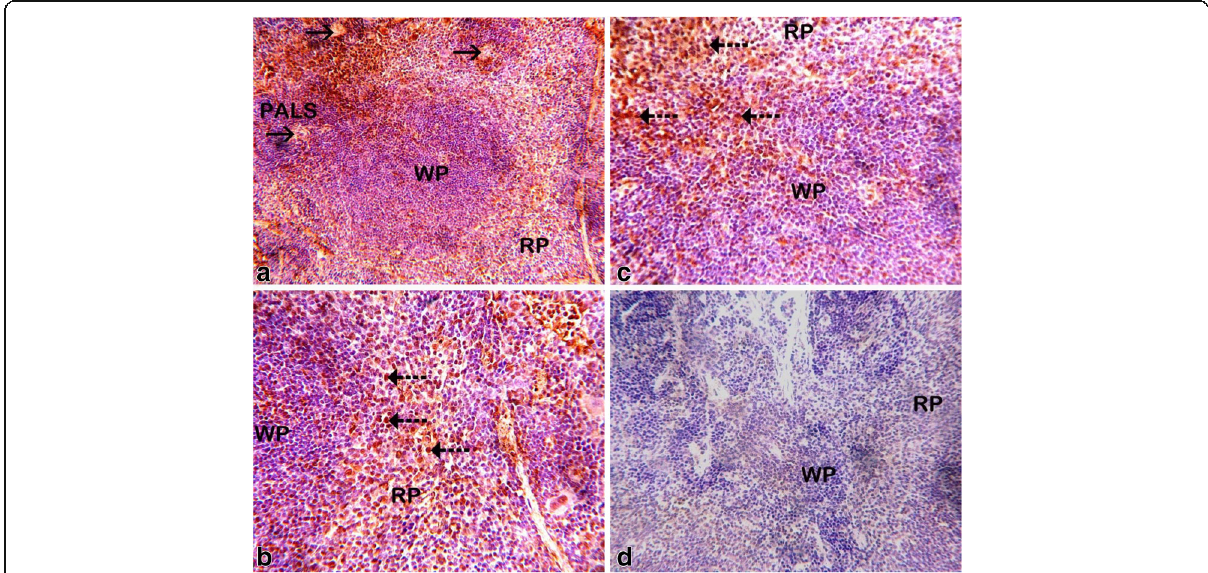
Fig. 11 Immunohistochemical images of the spleen section, from mice treated with TME at the rate of 1500 mg/kg, 8 hourly intervals for three days consecutively. In the white pulp, PALS region of the spleen surrounding central artery ( black arrows) appear darker as it is predominantly occupied by small lymphocyte in ( a ). In ( b and c ), detection of ssDNA in apoptotic cells, a marker for apoptosis is shown as a brown reaction due to DAB peroxidase reaction ( dotted line arrows ). The reaction is severe in the red pulp and areas on the marginal zone of the white pulp , some of the reactions are also seen in the PALS and the lymphoid follicles. Image D is from mice treated with PBSG at 0.1 ml/ 10 g as the extract at 8 hourly for three days consecutive for comparison. Magnifications, ( a ) 100 x; ( b , c and d ) 400 x